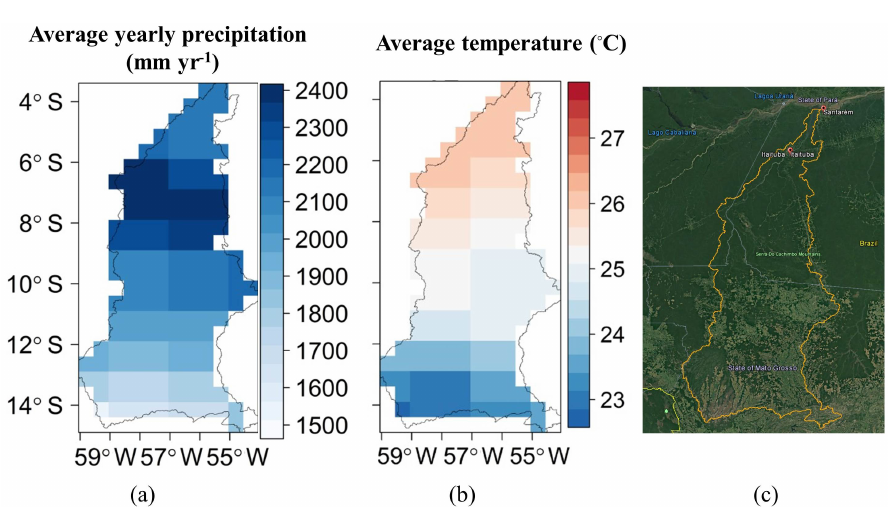
Figure 3. Average precipitation (a) and temperature (b) in the Tapajós River basin (1986–2005). Re-drafted from Farinosi et al. (2017). (c) Aerial imagery the Tapajós River basin illustrating land-cover diversity in the catchment. Source: Google Earth